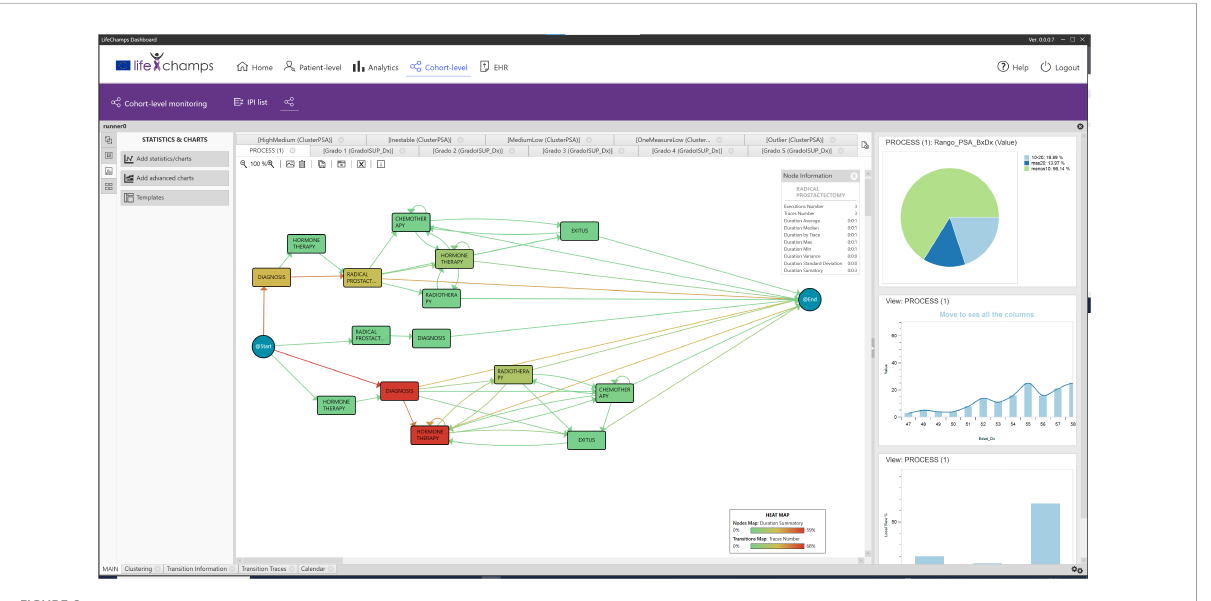
FIGURE 8 Statistics. IPI showing the statistics for Gleason Grade Group 1 about the PSA (ng/ml) range at diagnosis (less than 10, 10 – 20, more than 20), age at diagnosis, and treatment type for all patients.